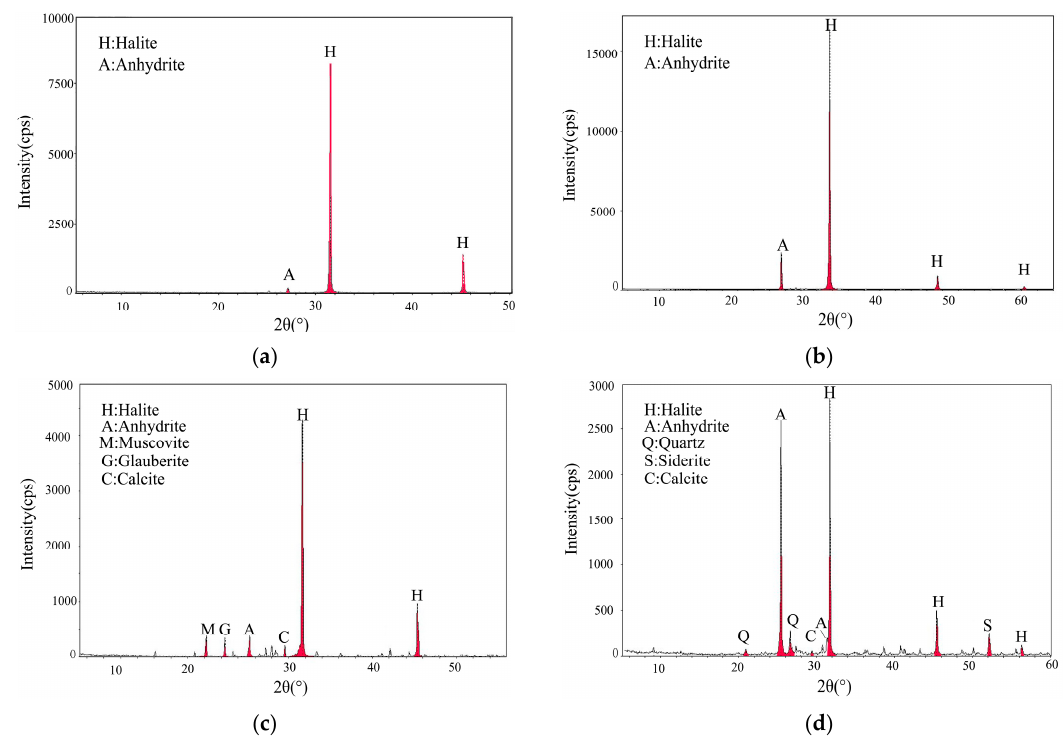
Figure 2. X-ray diffraction (XRD) analysis results of the salt rock specimens with different impurity contents. ( a ) Pure salt rock; ( b ) Salt rock with low impurity content; ( c ) Salt rock with medium impurity content; ( d ) Salt bearing sedimentary rock samples.